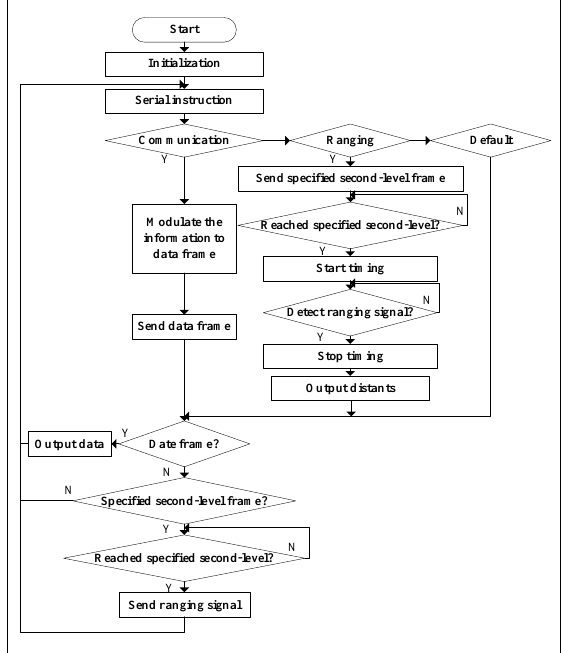
Figure 3. Flowchart of the proposed